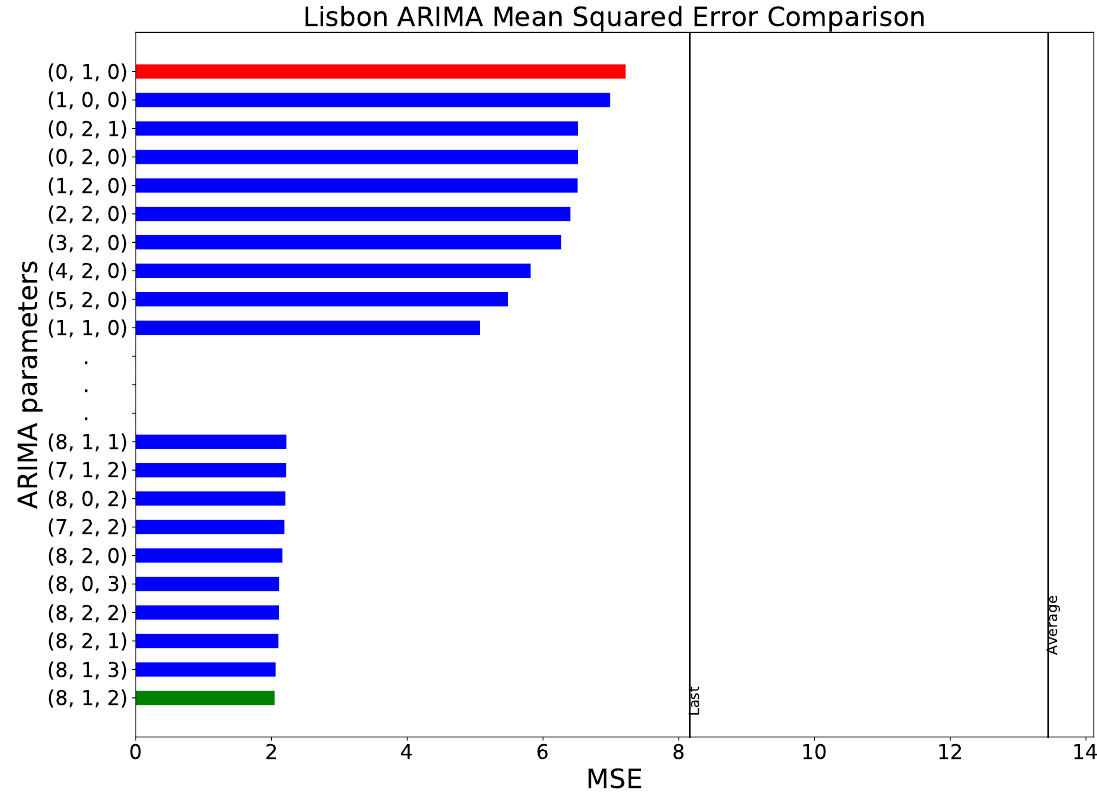
Figure 5. Comparison between different parametrisations of the ARIMA model, in terms of the MSE of the forecast, when applied to the Lisbon’s temperature data set. The red and green bars respectively indicate the worst and best set of parameters.